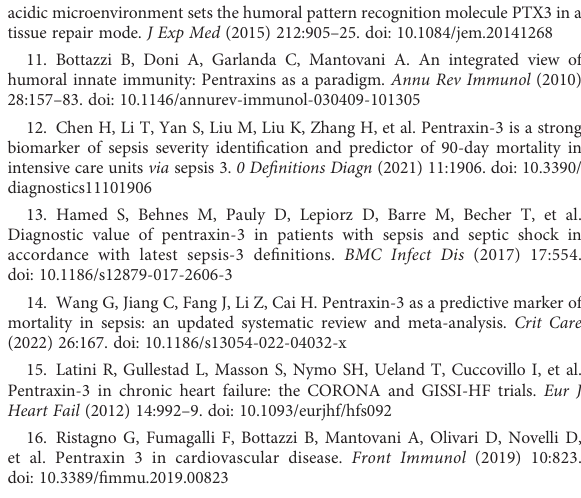
SUPPLEMENTARY FIGURE 1 Correlation matrix between levels of pentraxin 3, C-reactive protein, D- dimer and lymphocyte count. The table shows the correlation between variables. Each cell shows the correlation coef fi cient (Spearman) between the variables in the headers. P-values of all correlations were <0.01. SUPPLEMENTARY FIGURE 2 BaselinePTX3levelsamongpatientswithorwithoutpulmonaryembolism (A) or deep vein thrombosis (B) . P-values are from Mann-Whitney